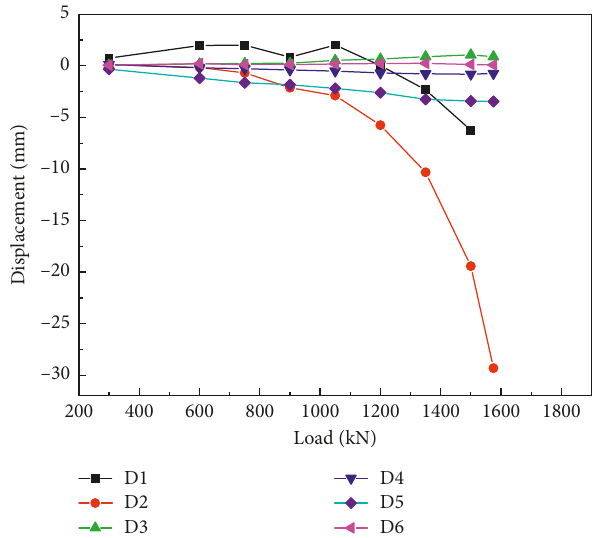
Figure 20: Load-displacement curves in Model